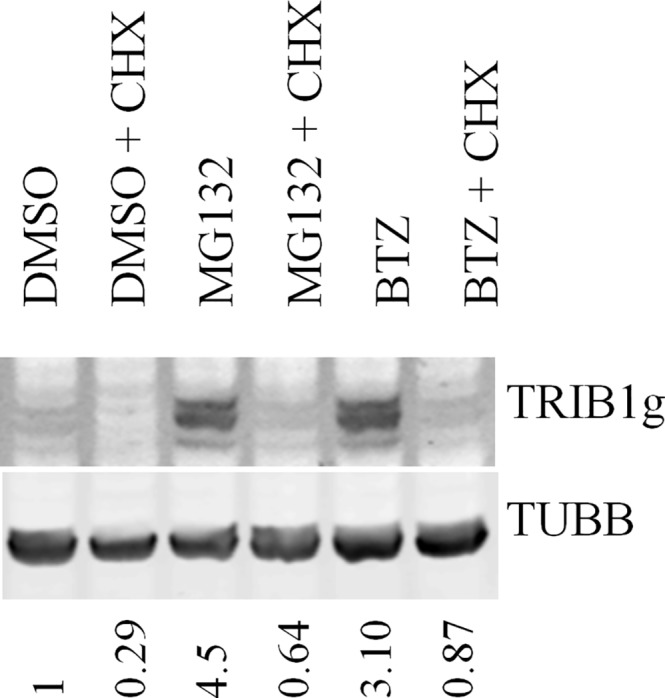
Minimal impact of untranslated regions on TRIB1 stability.Stable HeLa cell lines expressing TRIB1 with native 5’ and 3’ UTRs (HeLaT1UTR). Cells were treated with MG132 (20 μM) or BTZ (10 μM) or vehicle (0.1% DMSO) in the presence or absence of CHX for 5 h. Cells were lyzed and analyzed by western blotting using TRIB1 or TUBB antibodies. Data are representative of 3 biological replicates.